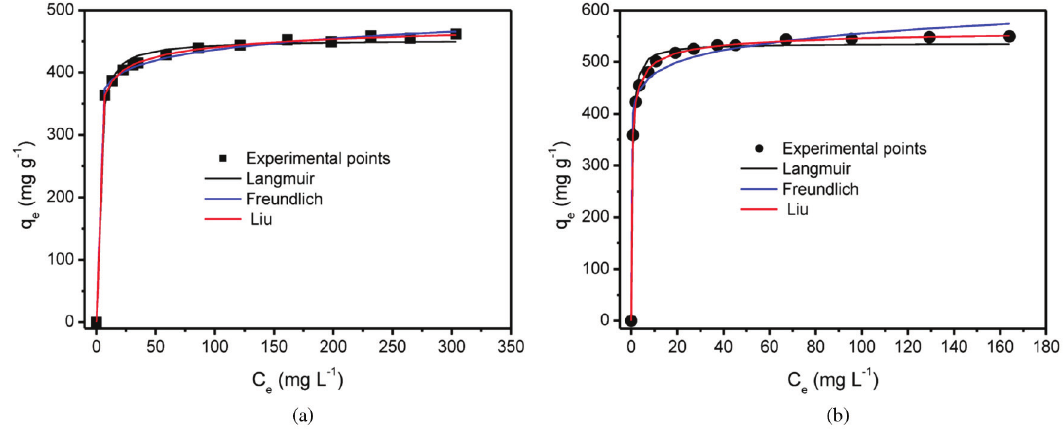
Figure 5. Isotherm curves of RB-4 adsorption at 323 K on (a) MWCNT and (b) SWCNT. Conditions: pH was fixed at 2.0; the adsorbent mass was fixed at 30.0 mg; the contact time was fixed at 4 Table 3. Liu isotherm parameters for RB-4 adsorption, using MWCNT and SWCNT as adsorbents. Conditions: adsorbent mass of 30.0 mg; pH fixed at 2.0, contact time 4 h. MWCNT 298 K